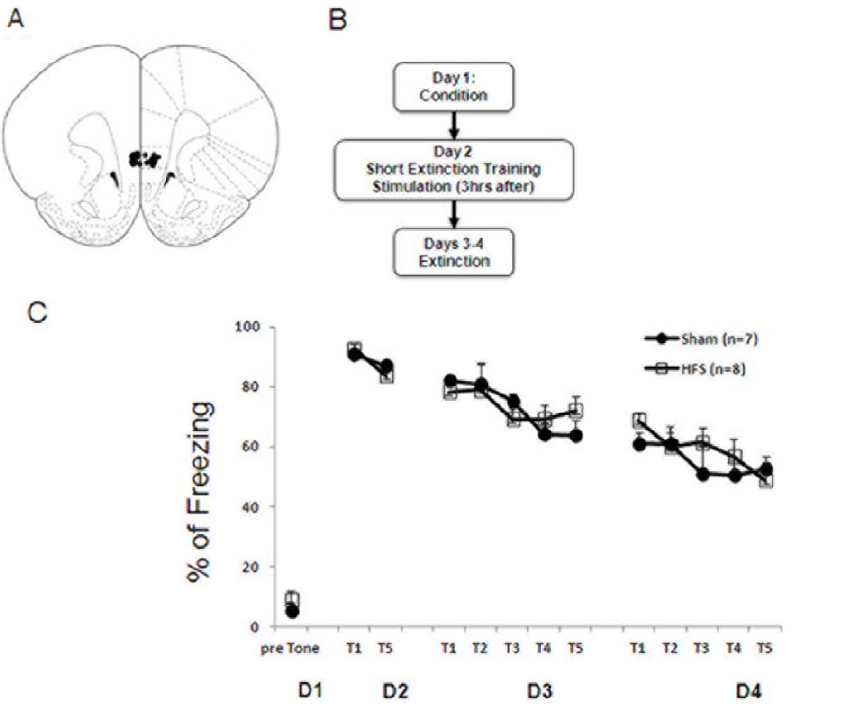
Figure 2. IL-HFS applied three hours after fear retrieval/short extinction training does not alter fear during extinction. ( A ) Schematic diagram showing electrode placement in IL [56] for the fear conditioning experiments. ( B ) Timeline of behavioral testing and stimulation. ( C ) Percent freezing to CS during conditioning, fear retrieval, and extinction in rats receiving either sham or HFS prior to conditioning. Sham and HFS rats did not differ during any phase. Data are Means 6